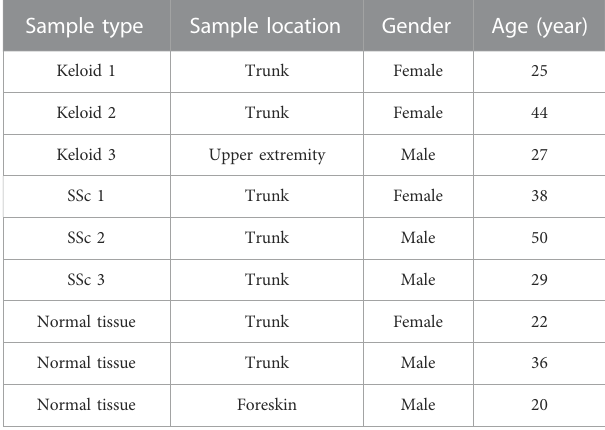
TABLE 1 Clinical information of validated